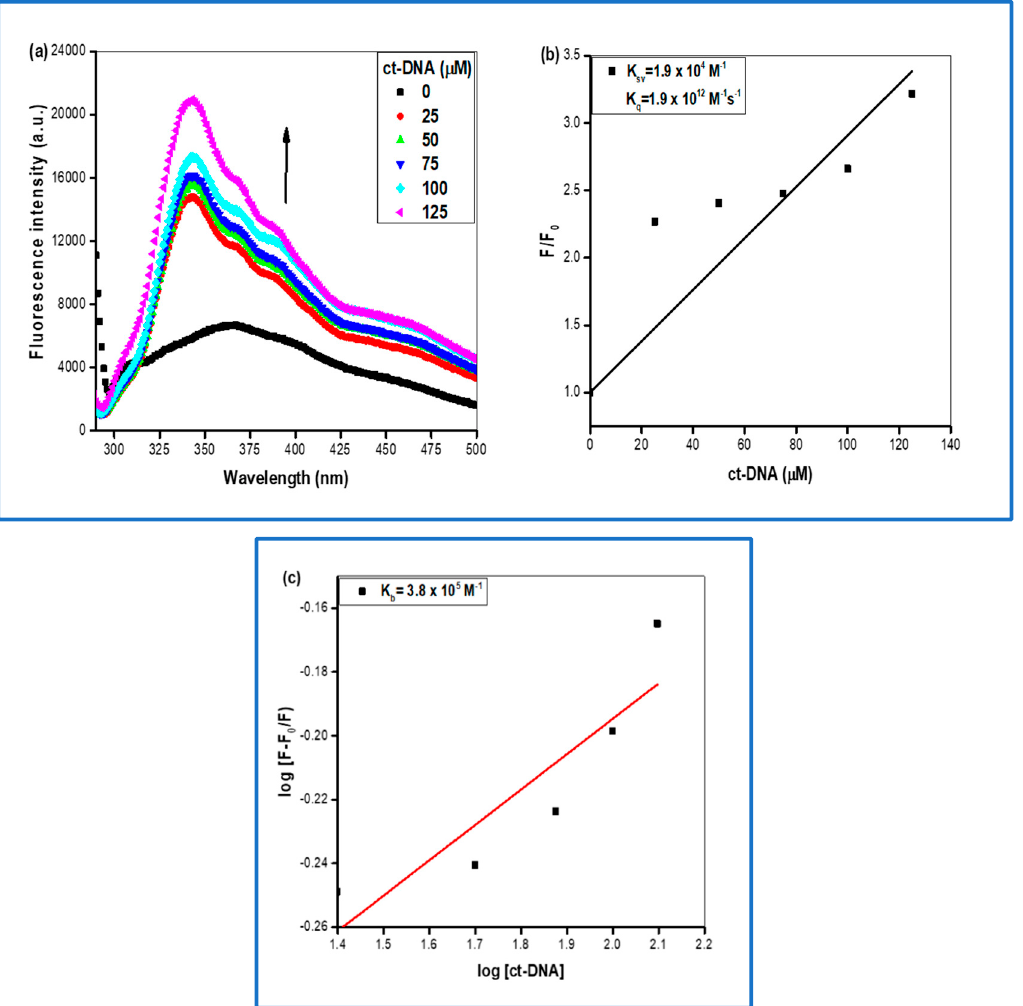
Figure 15. ( a ) Steady − state fluorescence spectra of compound 2 in the presence of increasing con- centration of ct-DNA (0–125 μ M). ( b ) Stern–Volmer plot of compound 2 complexed with ct-DNA to calculate K sv and K q . ( c ) Double logarithmic regression plot to calculate the binding constant (K b ). Table 4. From fluorescence measurements , values of Stern–Vomer, bimolecular enhancement con- stant, binding site number and binding constant achieved.